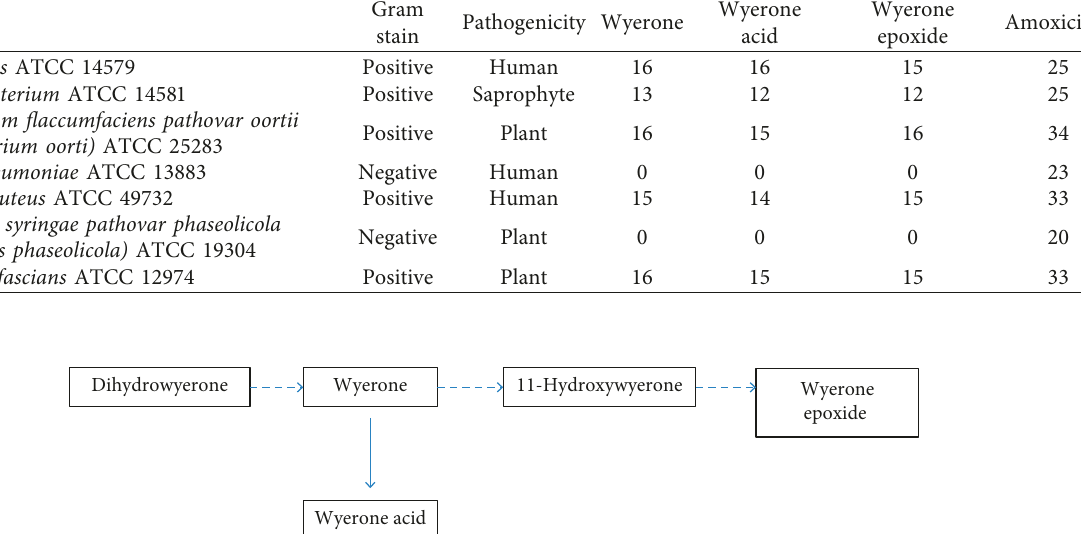
Figure 3: Isolation of a new compound, 11-hydroxywyerone, during the biosynthetic conversion of wyerone into wyerone epoxide. Dotted lines: the proposed pathway in the present study. Solid line: the previously reported conversion of wyerone into wyerone